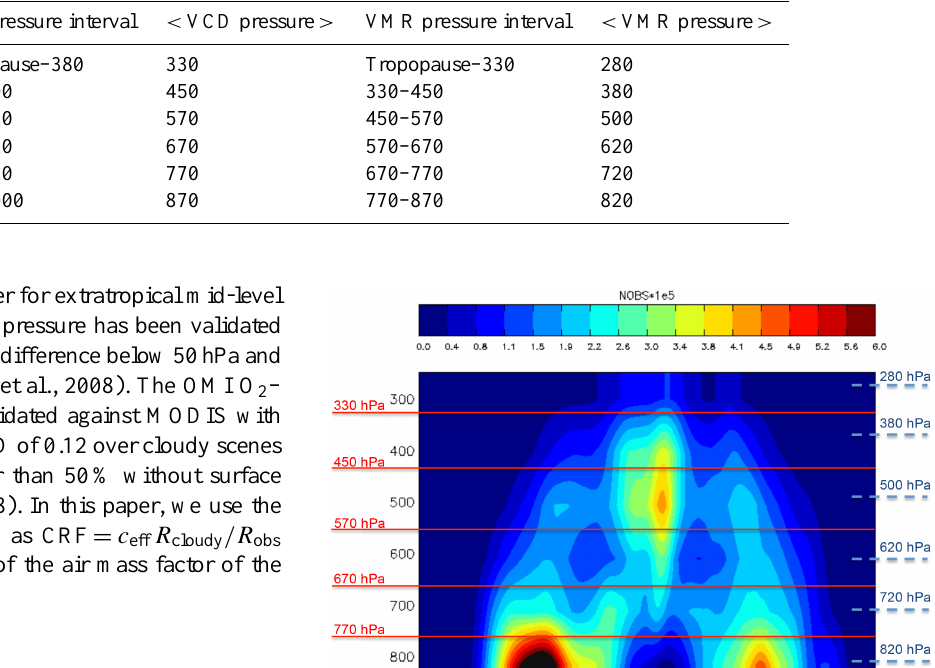
Table 1. Cloud pressure intervals and mean cloud pressure levels used for cloud slicing (hPa): the VCD pressure interval gives the boundaries of the cloud pressure bin. The VMR pressure interval refers to where the VMR is assumed constant after the pressure difference.